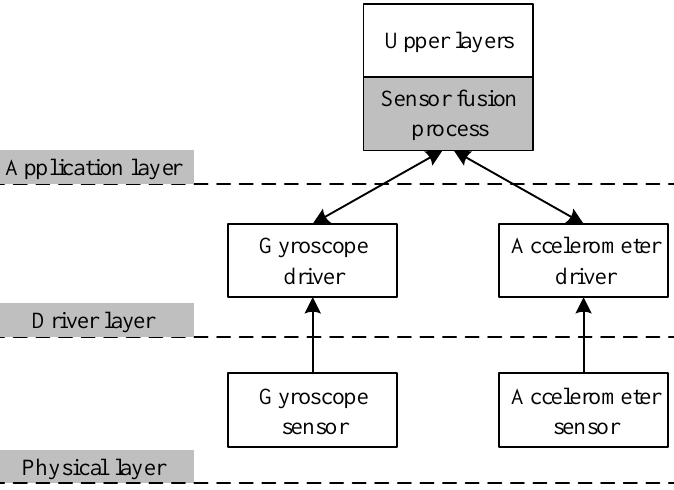
Figure 1. Sensor fusion processes in the legacy